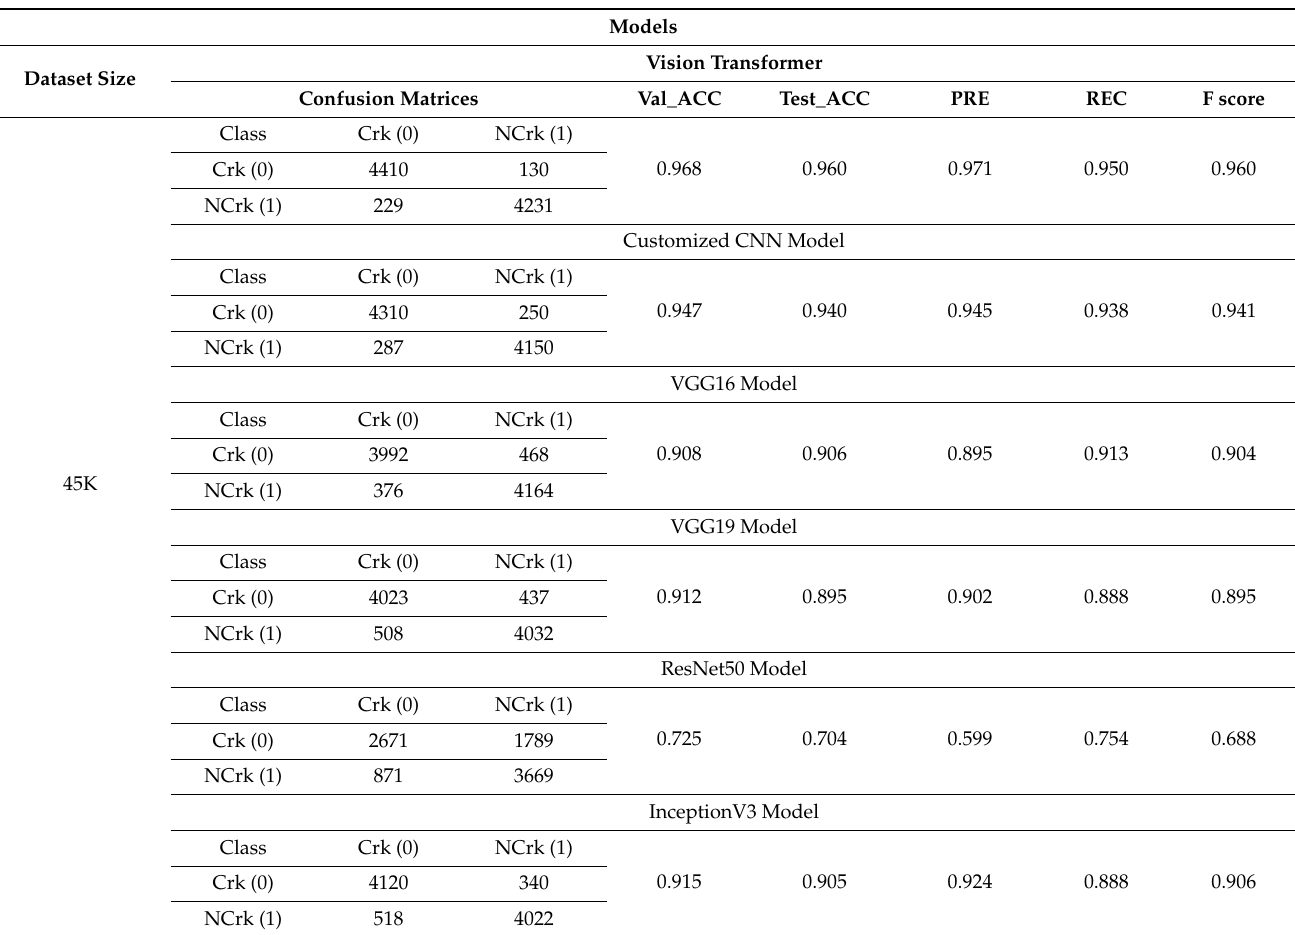
Table 3. All models’ experimental outcomes on pavement dataset (45K images).